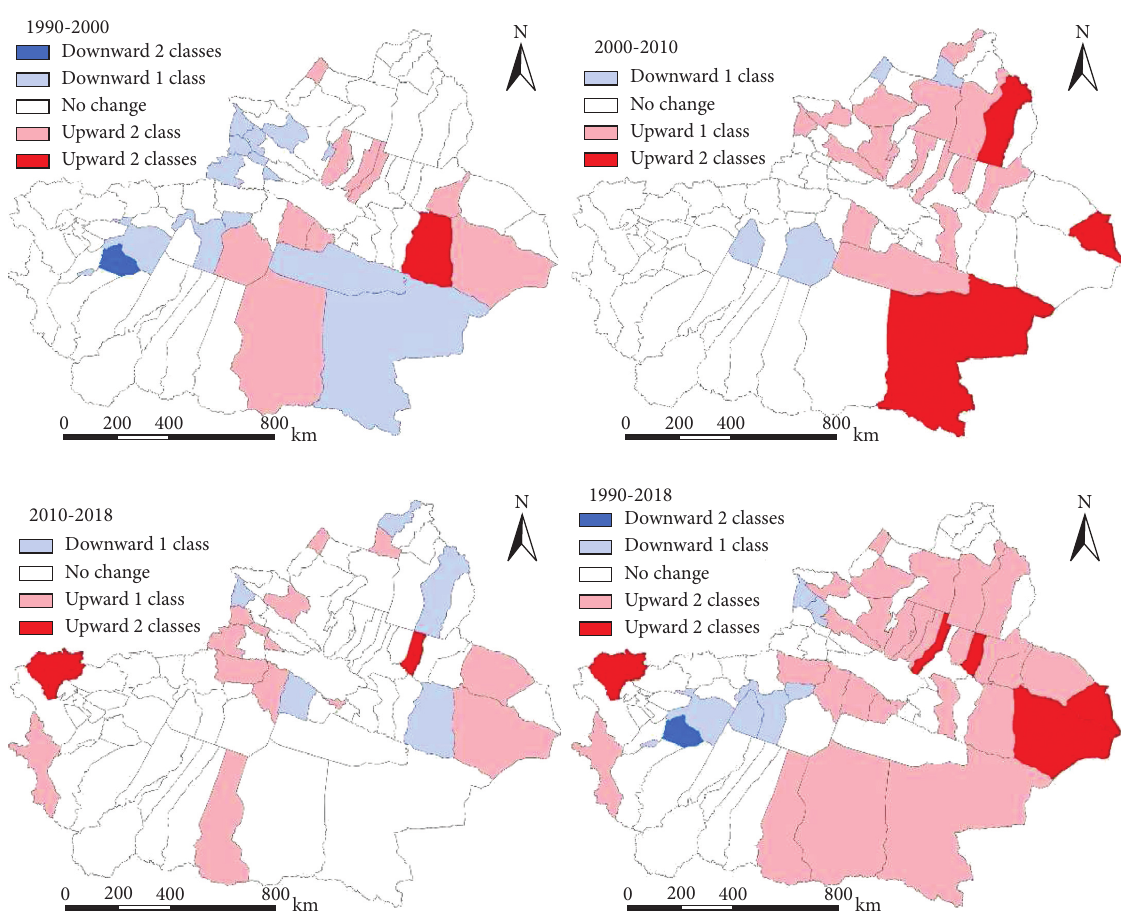
Figure 8: Place mobility map of per capita GDP in Xinjiang, 1990–2018. Table 3: Rank correlation analysis in different periods,